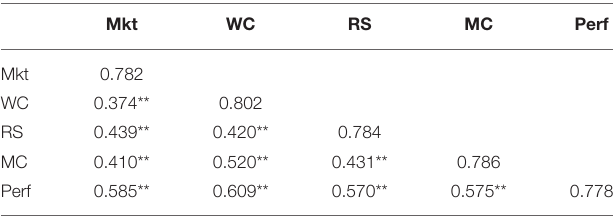
TABLE 6 | Discriminant validity test.